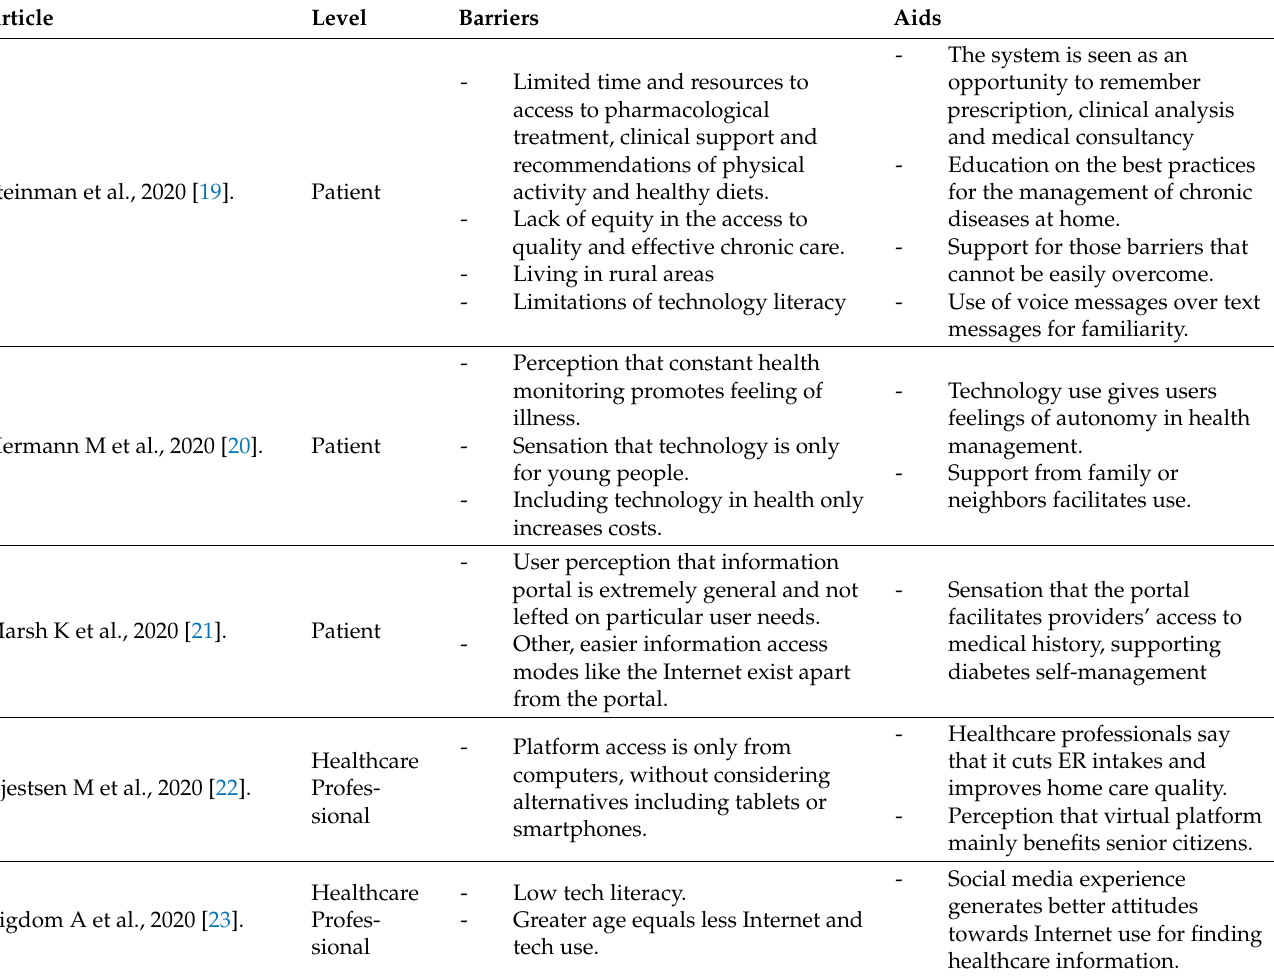
Table 2. Barriers and aids to eHealth interventions for users, healthcare professionals and healthcare